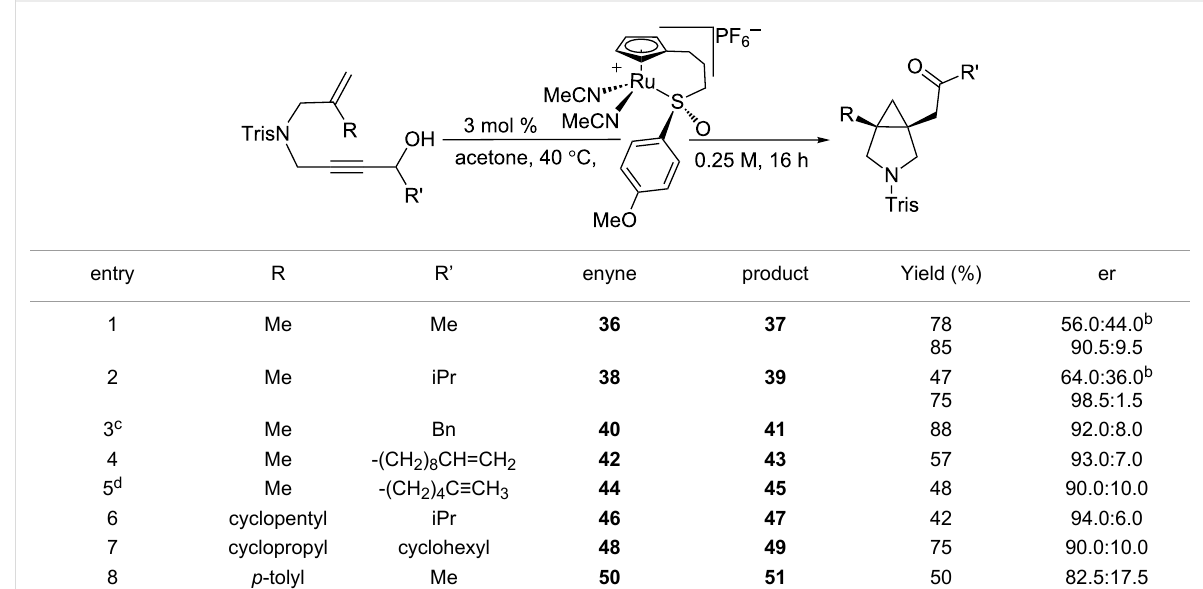
Table 6: Tris-protected [3.1.0] bicyclic pyrrolidines made by redox bicycloisomerization a .